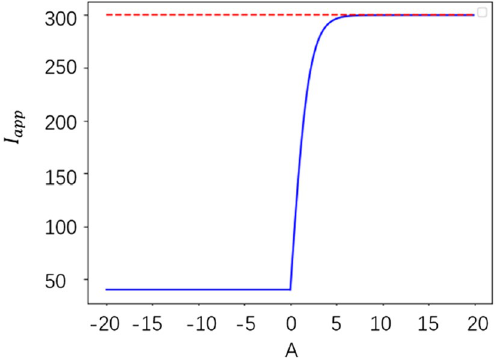
Figure 7. Ideal A and I app mapping